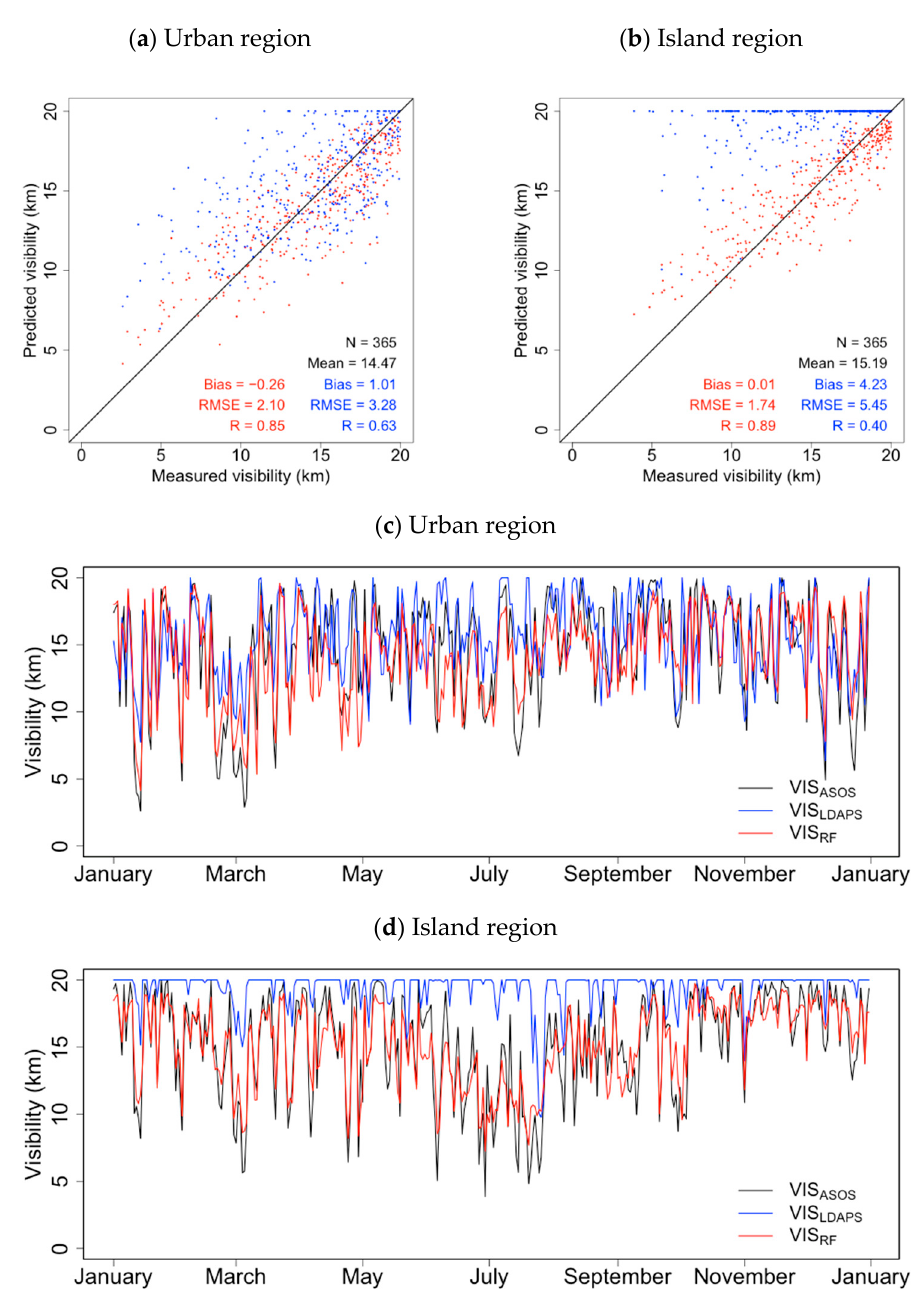
Figure 6. Scatter and time-series plots of VIS ASOS and VIS LDAPS ( a ) and VIS RF ( b ) in urban and island regions ( c , d ) in 2019. Red dots indicate VIS ASOS vs. VIS RF and blue dots indicate VIS ASOS vs. VIS LDAPS .